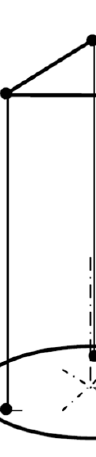
Figure 5. Displacement of the rotation body with labeled angles and lengths. Because of the enhanced stability, trifilar pendulums with three threads are used in most applications. With this setup, the time period depends again directly on the MOI. The parameters needed to calculate the inertia around a vertical axis are the length L of the threads, the distance R between the threads and rotation axis, the mass m , and the period T of oscillation. After measuring these parameters, the pendulum MOIs, I , can be calculated according to Equation (3).